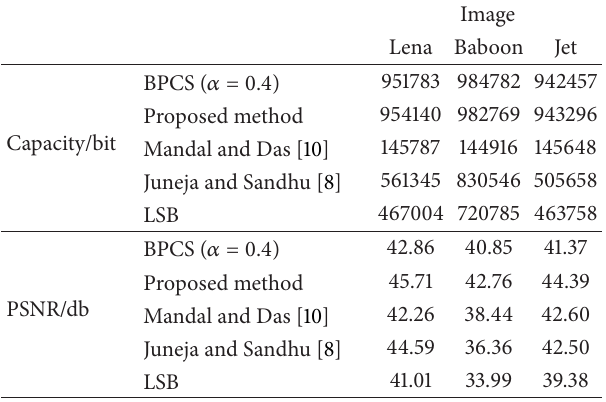
Table 1: Comparison of PSNR value and capacity with different methods.